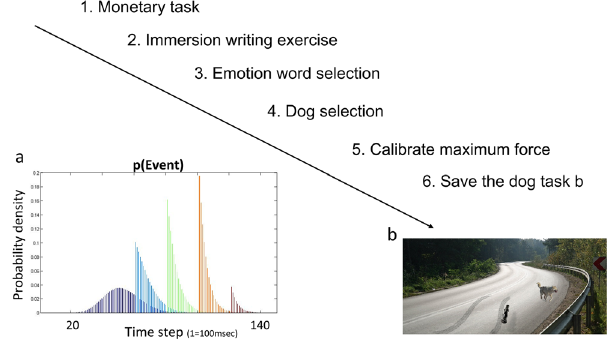
Figure 1. Task stages. Participants first completed a practice monetary task, then an immersion exercise writing about a pet (real or hypothetical) who died, then briefly selected preferred emotional words (for use in the in- task questions), then selected a preferred dog, and finally exerted their maximum force before beginning the task (1b). How the conditional distribution of the car arriving changed with time within a trial is shown in 1a. Each trial was structured in 100 msec time steps. The distribution at 0 sec is shown in purple; this gradually changes, given that no car arrives, to the brown at t = 12 sec. (based on previous work 11 ). For most trials, the more time had passed, the more likely it was that the car was about to arrive (blue to orange). Towards the very end of the trial, however, it became more likely that no car would appear at all. The following image used in Fig. 1b is reproduced under the terms of a Creative Commons 2.0 generic license (https://creativecommons. org/licenses/by/2.0/legalcode) and has been adapted from its original form (Original Author: Drew Avery; title: Annual Dog Sled Race). The link to the original image is: https://www.flickr.com/photos/33590535@ N06/5391571785/in/photostream/ The following image used in Fig. 1b is reproduced under the terms of a ultrasound whistle). The link to the original image is: https://commons.wikimedia.org/wiki/File:Hundepfeife05. JPG. The following image was reproduced under the terms of a Freeimages Content License (Author: